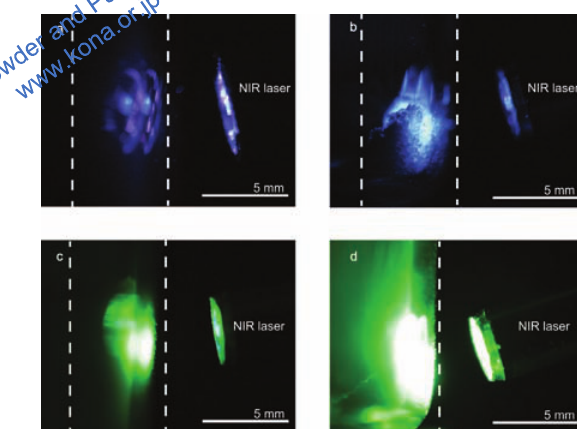
Fig. 6 Photographs of the UC luminescence of Yb 3 + , Tm 3 + (a, b) and Yb 3 + , Er 3 + (c, d)-doped nano- phosphors. The thermal treatment of powders at 800 ℃ significantly increased the intensity of the visible emissions for the Yb 3 + , Tm 3 + (b) and the Yb 3 + , Er 3 + (d)